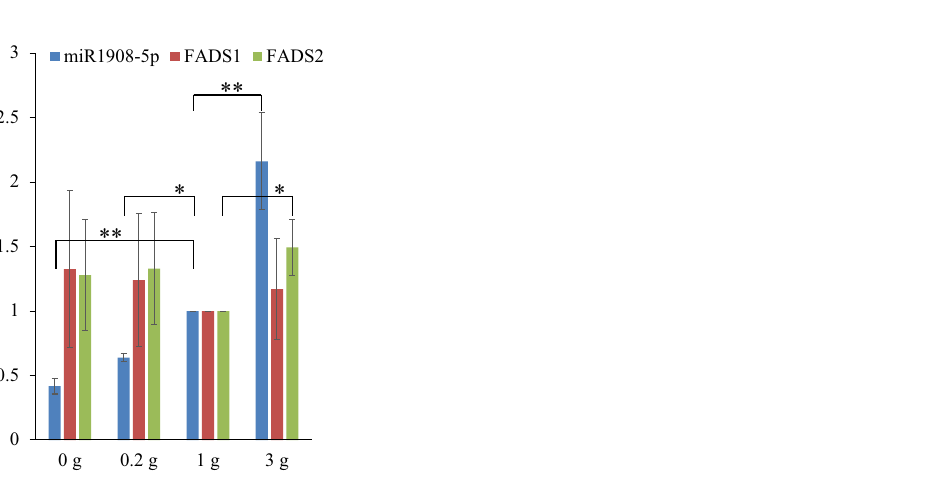
Figure 2. Cellular miR-1908-5p expression is proportional to media glucose concentration in HuH-7 cells. HuH-7 cells were maintained in variable concentrations of glucose (in pyruvate-free media) for 72 h. Cells were lysed, RNA isolated and miR-16, RNU48 and miR1908-5p were quantified by qRT-PCR. Values were normalized using the ΔCp method, using RNU48 and miR1908-5p average value as a reference. Results are expressed relative to the corresponding euglycemic (1 g/L) condition value. The error bars depict the SD. X g/L glucose vs 1 g/L glucose: ** p < 0.01; * p <